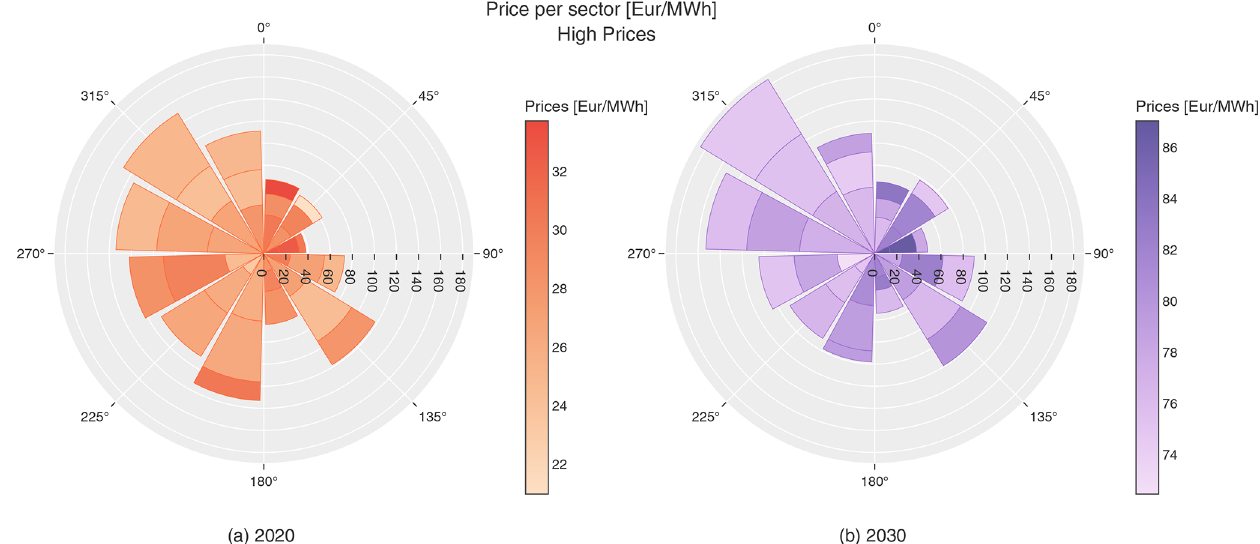
Figure 1. Distribution of day-ahead electricity prices per binned wind sector in 2020 (a) and 2030 (b) for the high-price scenarios included in the present analysis. Sectors represent the wind direction bins ( ± 15 ◦ ). Each sector includes 7, 9 and 11ms − 1 ( ± 1ms − 1 ) wind speed bins in stacked form following that sequential order from the origin. Radial length of the polar plots indicates the number of samples per bin. The colour scale represents the prices per bin for both 2020 (a) and 2030 (b) scenarios.